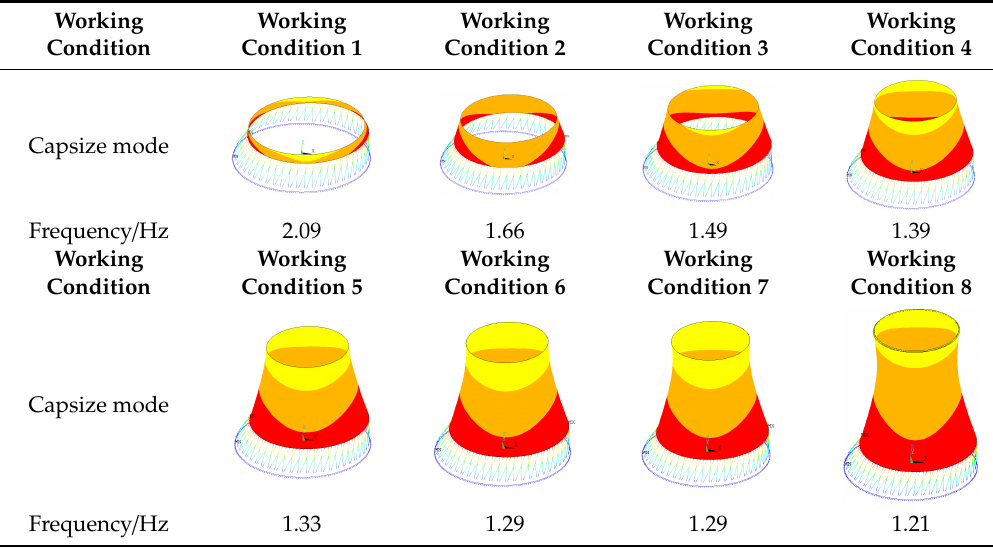
Table 4. Capsize modes of the cooling tower for the whole construction process.